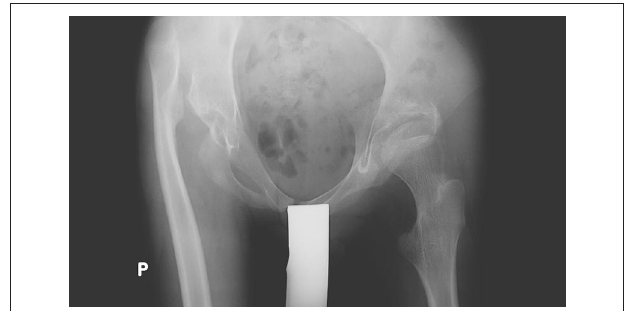
FIGURE 1 | 17 y old, male, treated because painful hip dislocation.